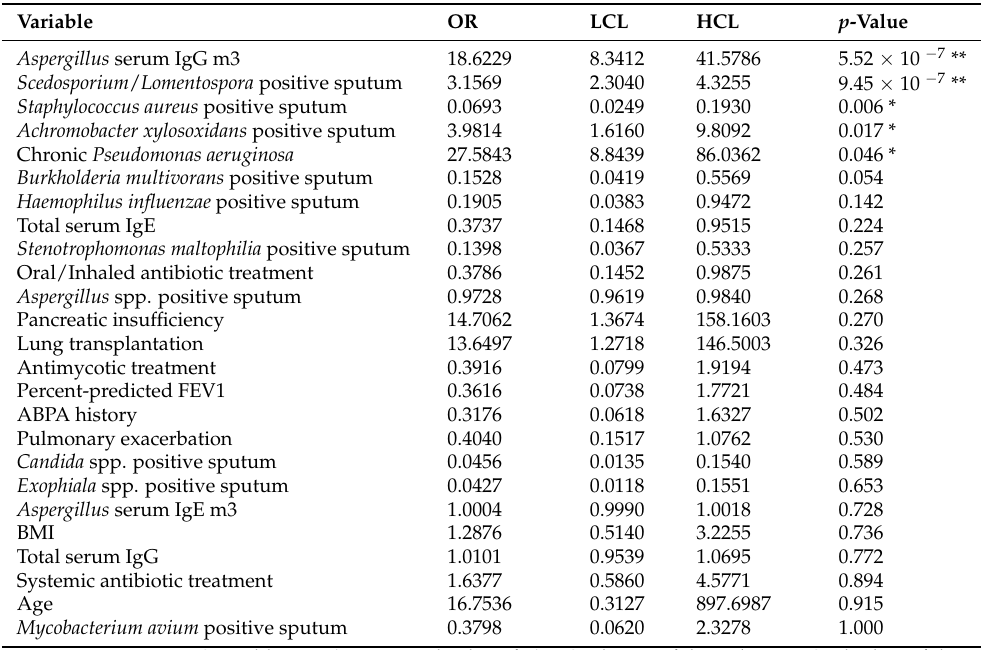
Table 4. Adjusted odds ratios of association factors for Scedosporium / Lomentospora -IgG DIA posi- tive